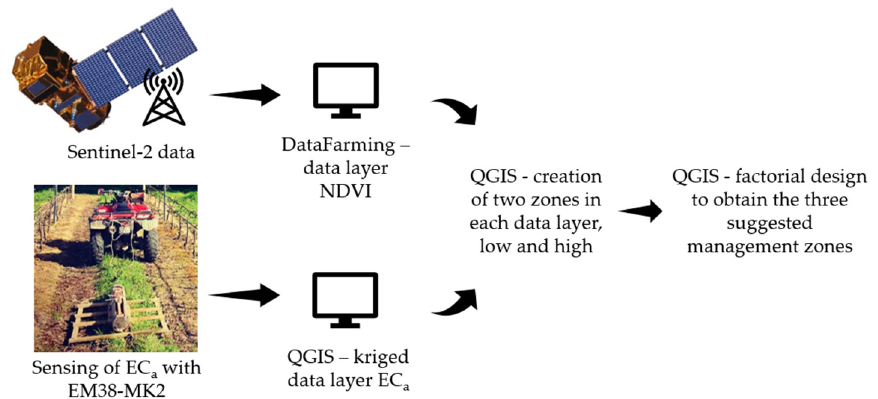
Figure 1. Summary of the procedures performed to obtain the EC a map, the NDVI map, and the map with the three distinct zones in terms of these two indicators.